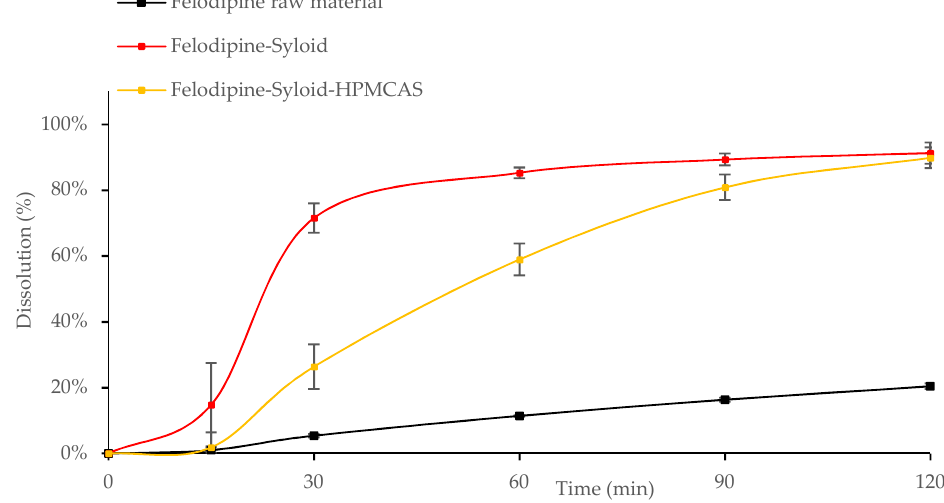
Figure 10. Release profiles of the raw Felodipine material, Felodipine-Syloid, and Felodipine-Syloid-HPMCAS at drug load of 300% monolayer coverage. Testing conditions: phosphate buffer pH 6.5 + 0.25% SLS, 500 mL, USP apparatus 1, 50 rpm.